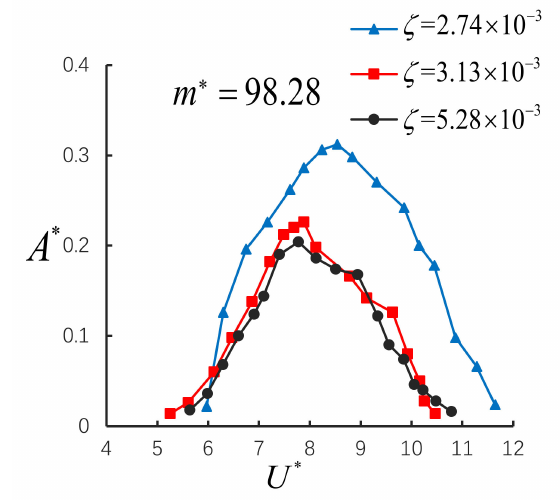
Figure 6. A ∗ with the change of U ∗ of experiment